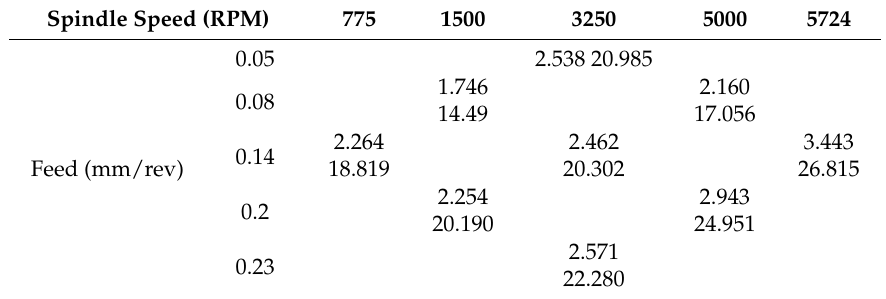
Table 3. Effect of the drilling conditions on the average Ra ( top ) and the average Rt ( bottom ), in µ m. Spindle Speed (RPM) 775 1500 3250